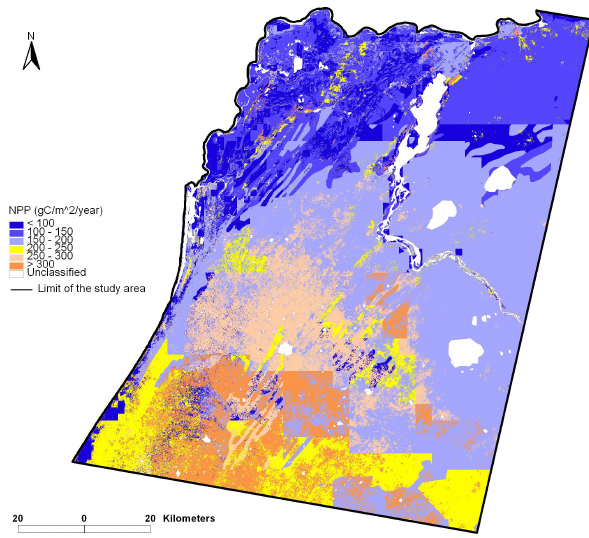
Fig. 4. GEMS net primary productivity (NPP) model output for 2000 using the 9 class 28.5m Landsat hard decision tree classifi- cation illustrated in Fig. 1 and the corresponding spatially explicit model inputs for the 9 LCLU classes. White shows areas where no NPP was modeled (water bodies, clouds, cloud shadows, settlement areas, or no Landsat